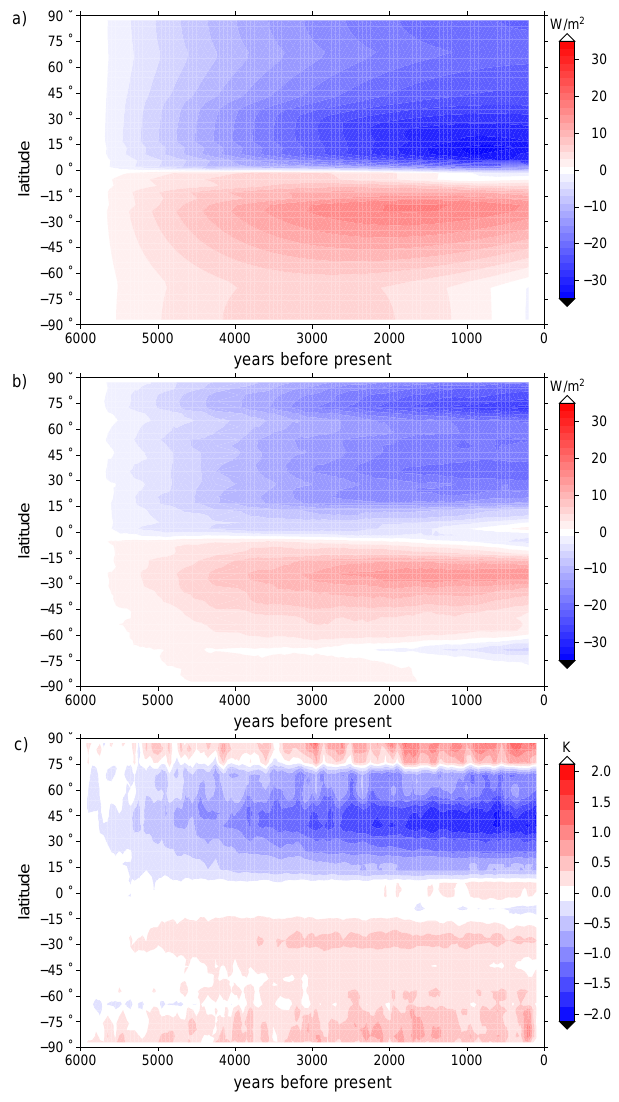
Fig. 1. Zonal mean Hovmoeller type diagrams of a) seasonal insolation cycle amplitude (difference between yearly maximum and minimum insolation in W/m 2 ), b) seasonal net insolation cycle amplitude (including planetary albedo), and c) seasonal temperature cycle amplitude (difference between annual maximum and minimum zonal mean temperature). The panels show anomalies with respect to conditions at the mid-Holocene (mean of the first 100 years of the simulation).